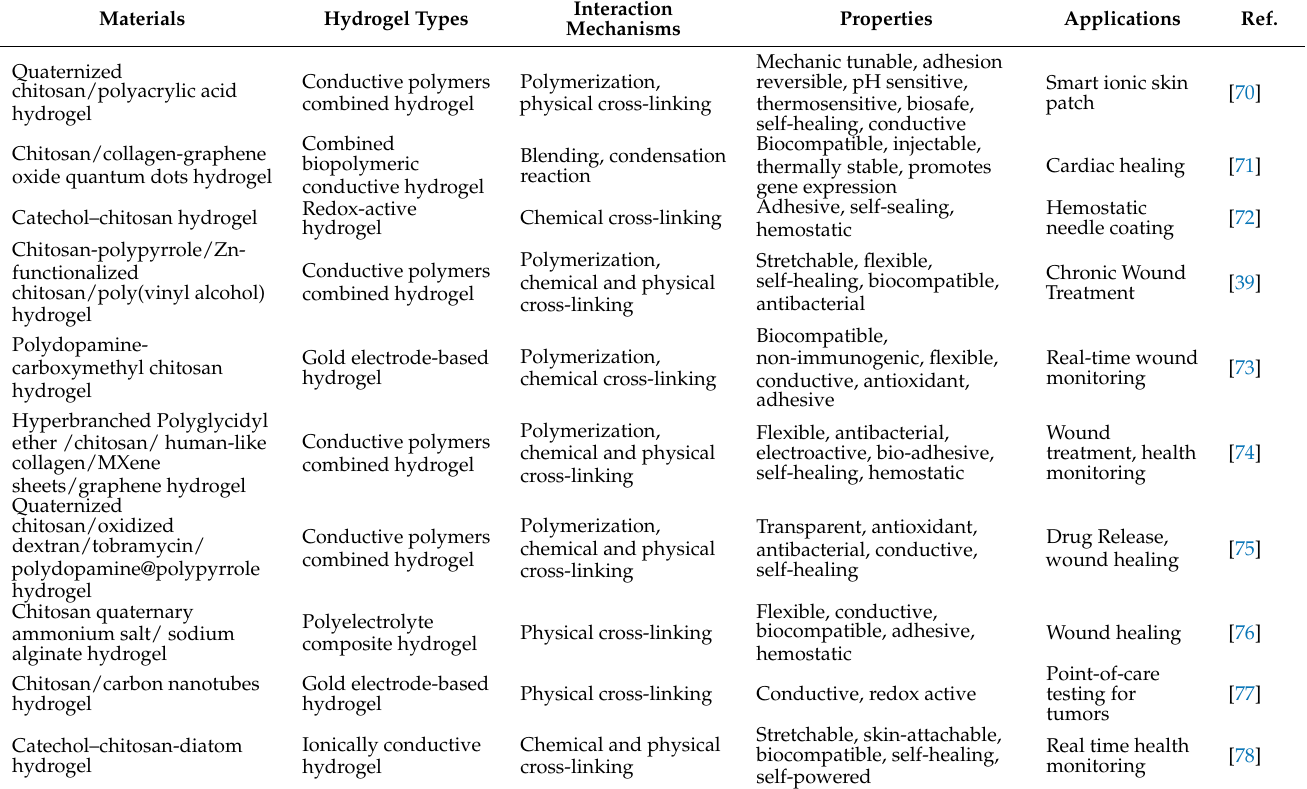
Table 1. Chitosan-based bioelectronic sensing and its biomedical